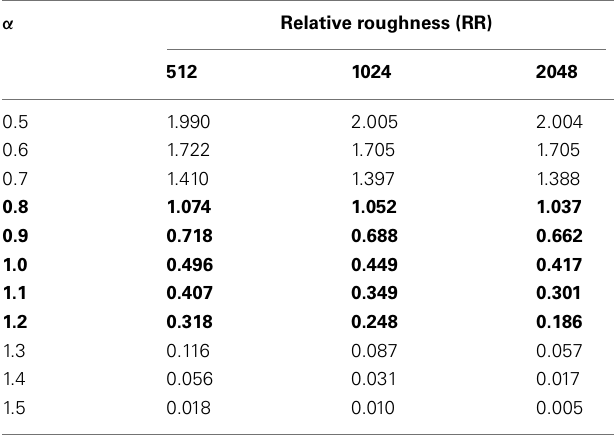
Table 1 | Mean relative roughness (RR), computed for exact fractal series with α exponents ranging from 0.5 to